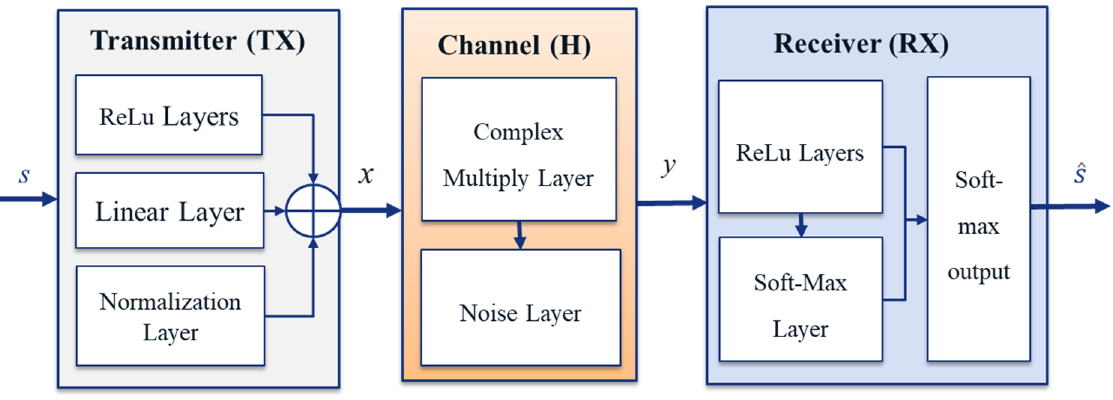
Figure 10. An illustration of a MIMO channel autoencoder.